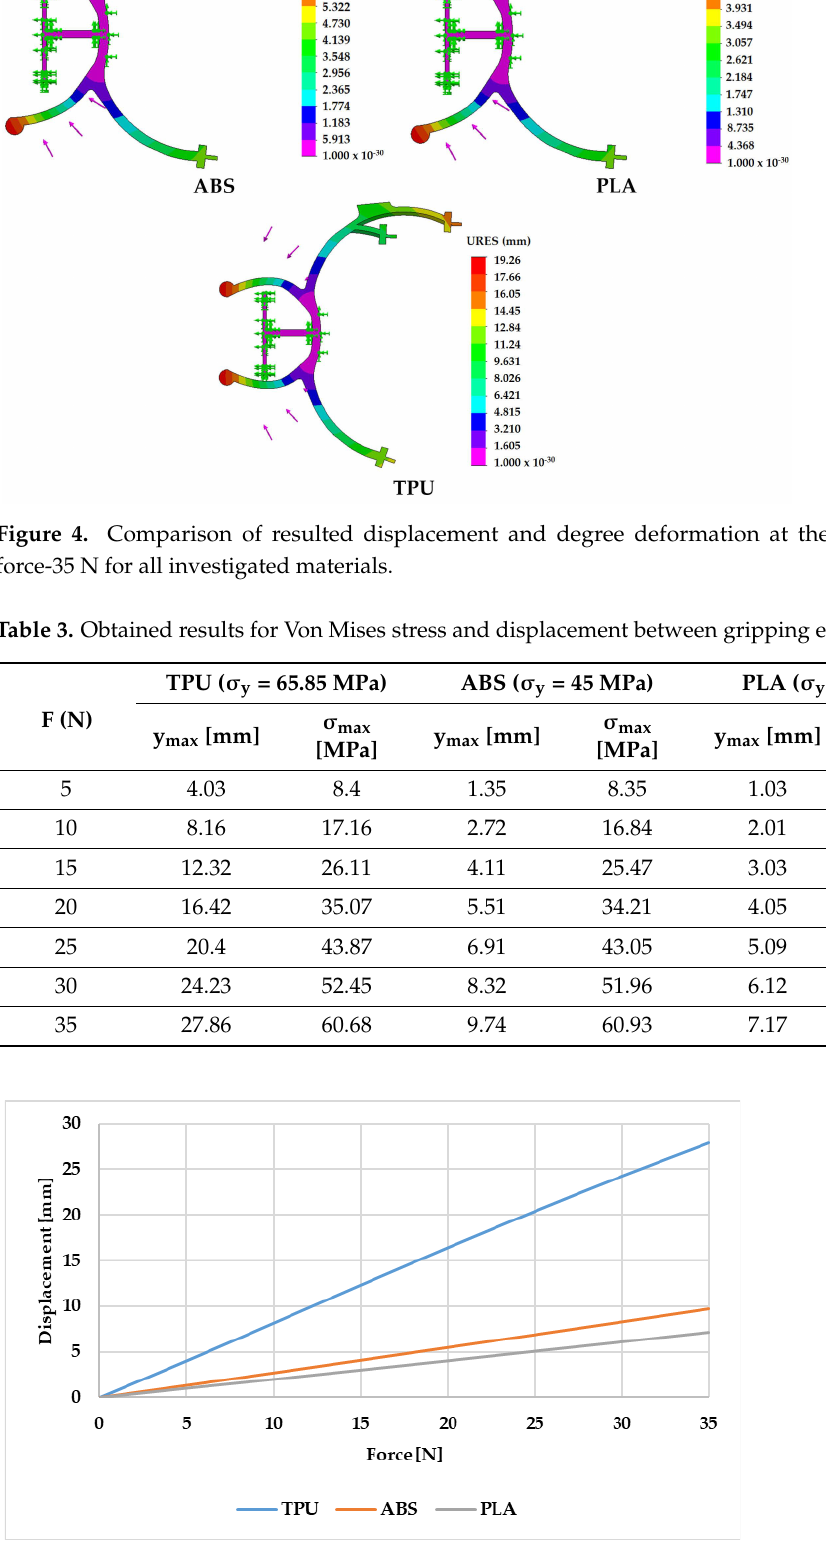
Figure 5. Comparison of force-displacement characteristics for investigated materials.